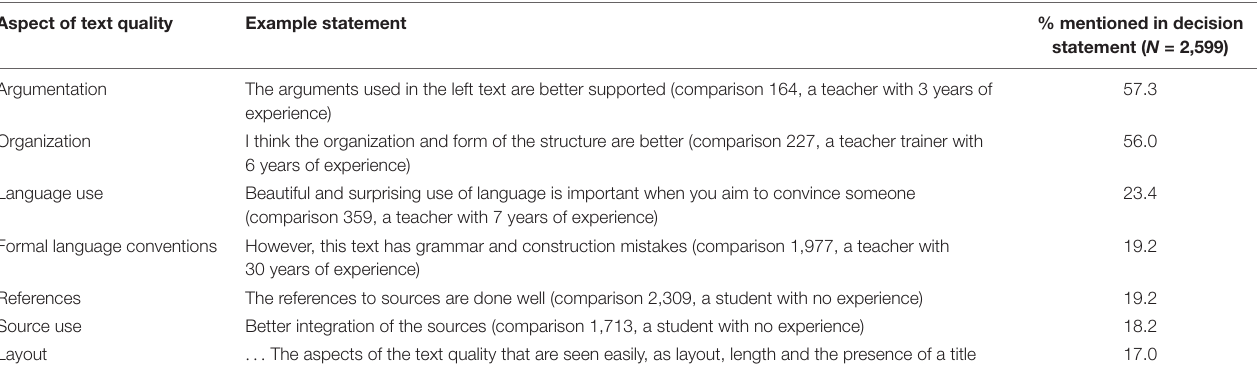
TABLE 1 | Coding scheme with example statements and percentages elements were mentioned.